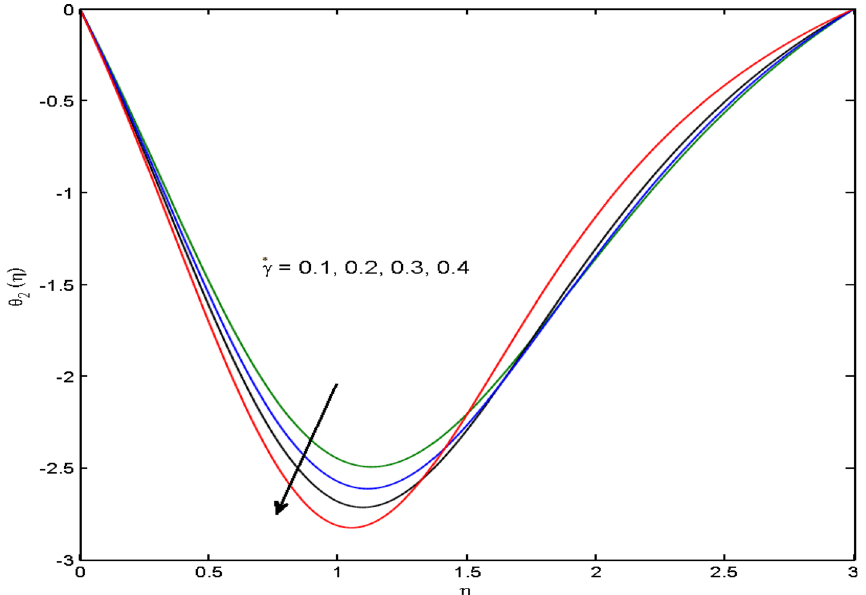
Figure 9. θ 2 (η) versus varied estimates of γ ∗ .